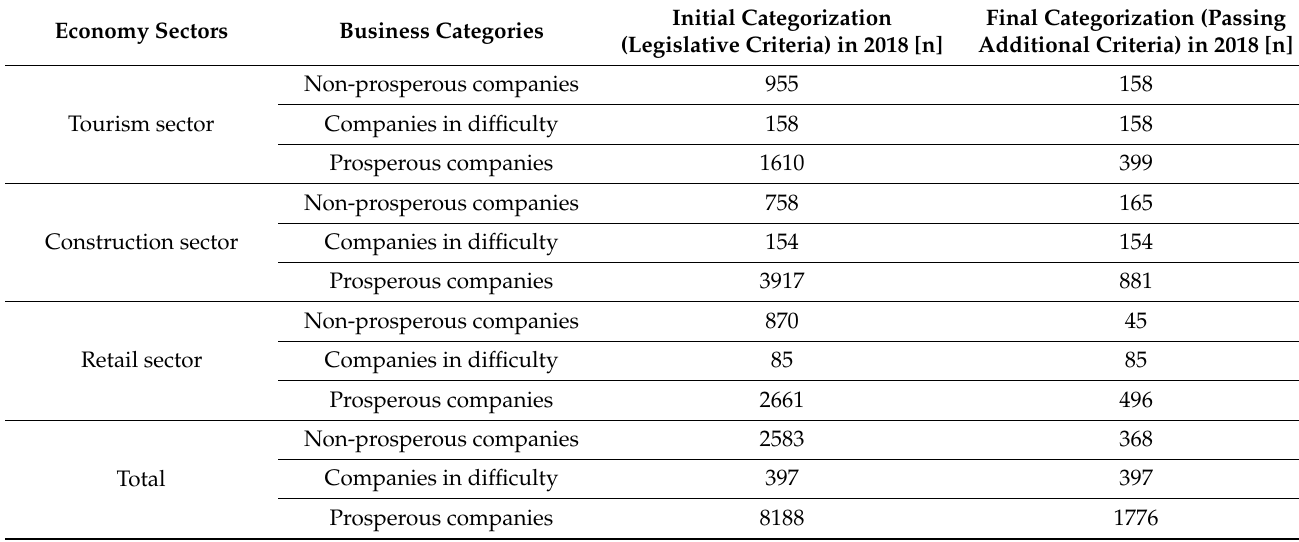
Table 2. Share of prosperous and non-prosperous companies in selected sectors in